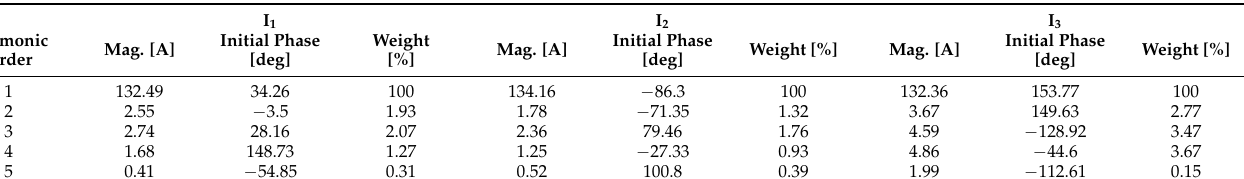
Table 4. Parameters of the most significant harmonics of the phase currents—after compensation, case γ .